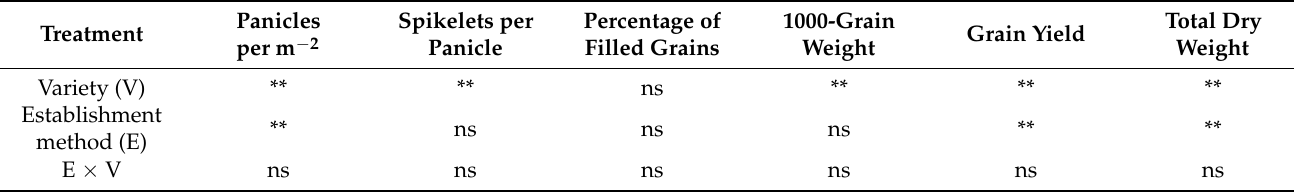
Table 3. Analysis of variance (ANOVA) for yield and yield-related traits.